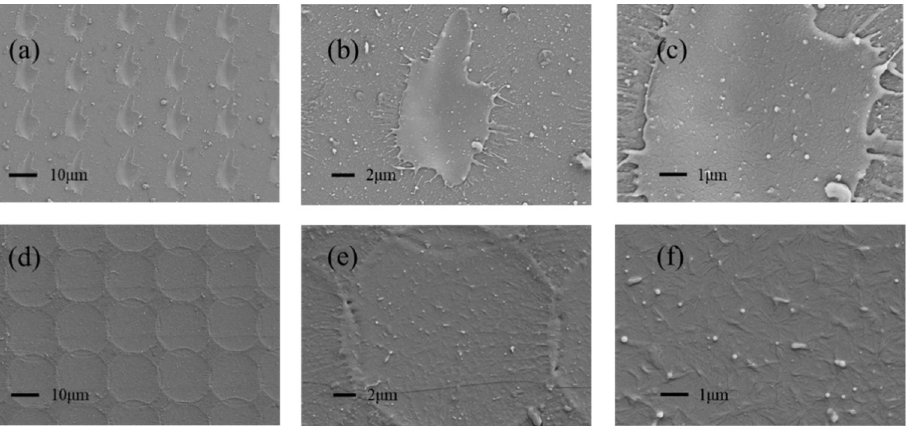
Figure 4. SEM images of the glasses textured by different lasers. ( a – c ) ultraviolet femtosecond laser, ( d – f ) infrared femtosecond laser. ( d – f ) infrared femtosecond laser.